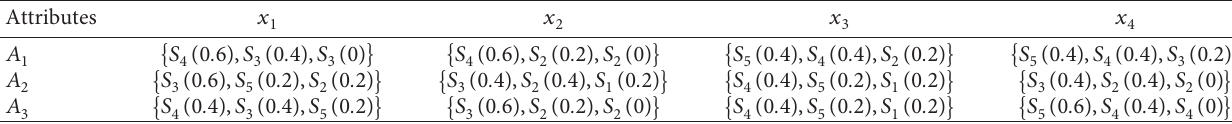
Table 27: The normalized probabilistic linguistic decision matrix of the group.